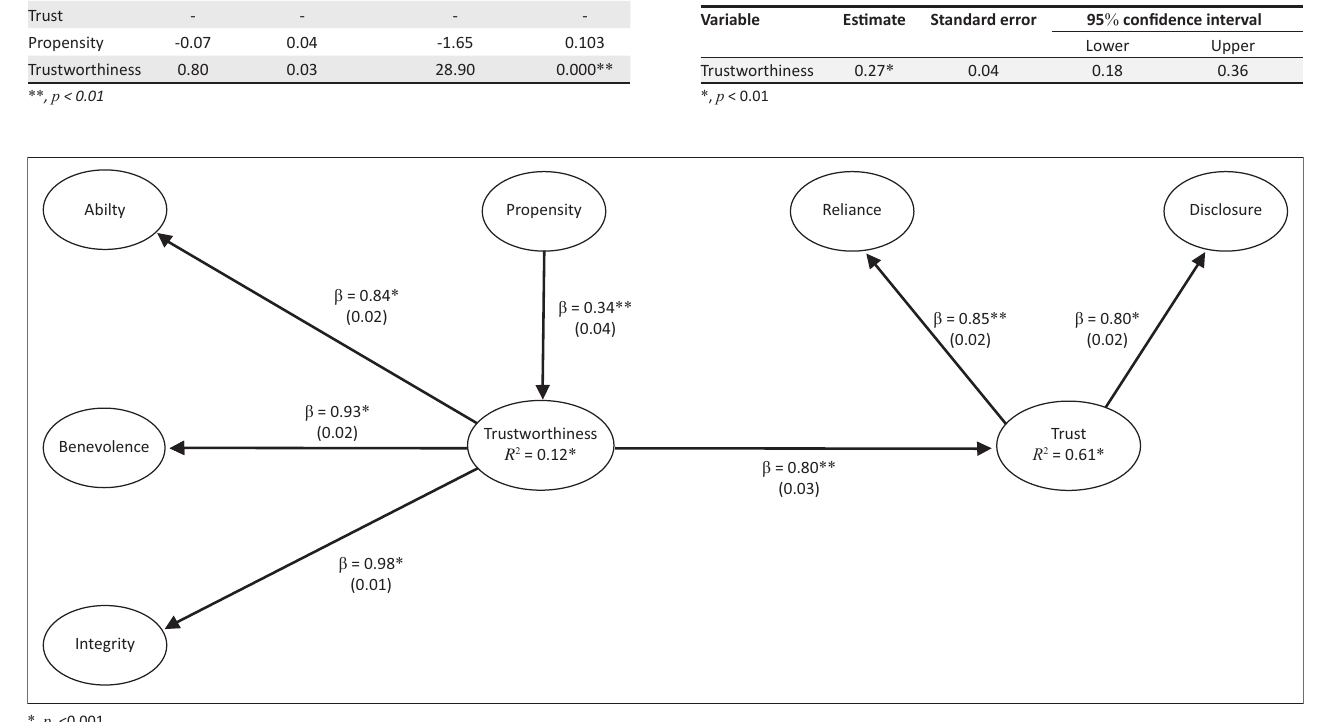
FIGURE 2: The structural model (standardised solution with standard errors in parentheses).